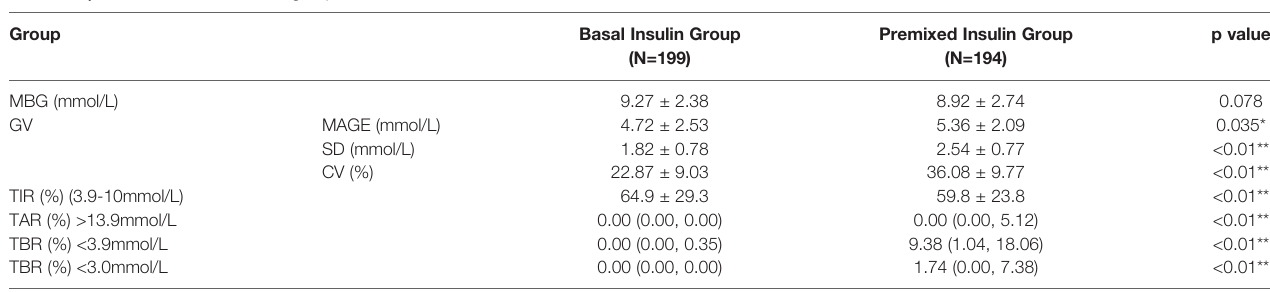
TABLE 3 | CGM index between two